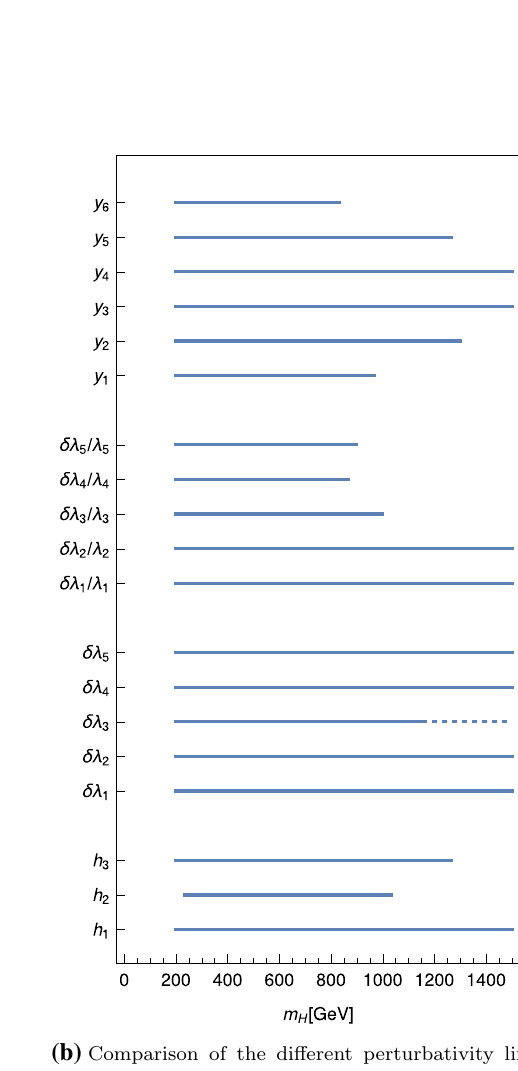
(b) Comparison of the different perturbativity limits. See Fig. 4 for more details.